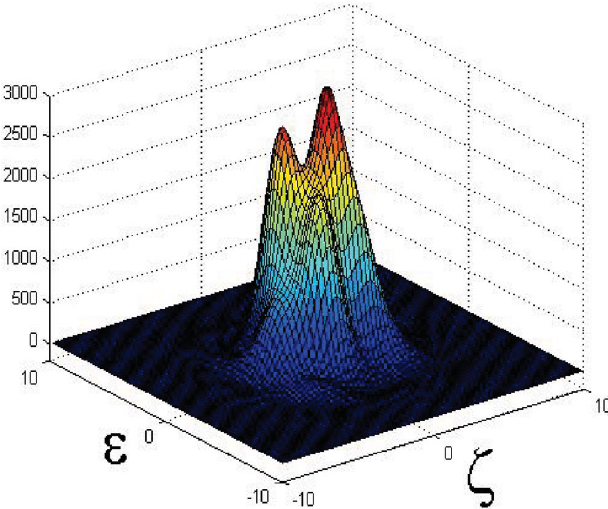
FIG. 9. (Color) Longitudinal phase-space reconstruction of the electron beam in giant pulse mode at turn 280. The distribution has separated into two distinct peaks, indicating the ‘‘burning out’’ of electrons at (cid:4) (cid:3) 0